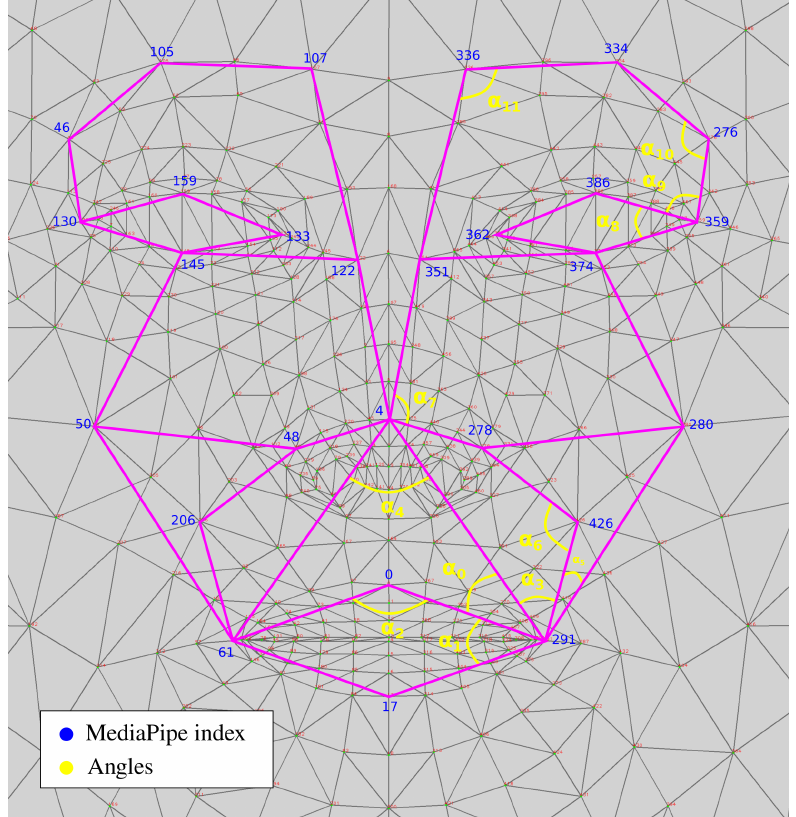
Figure 7. All angles on the right side of the emotional mesh .